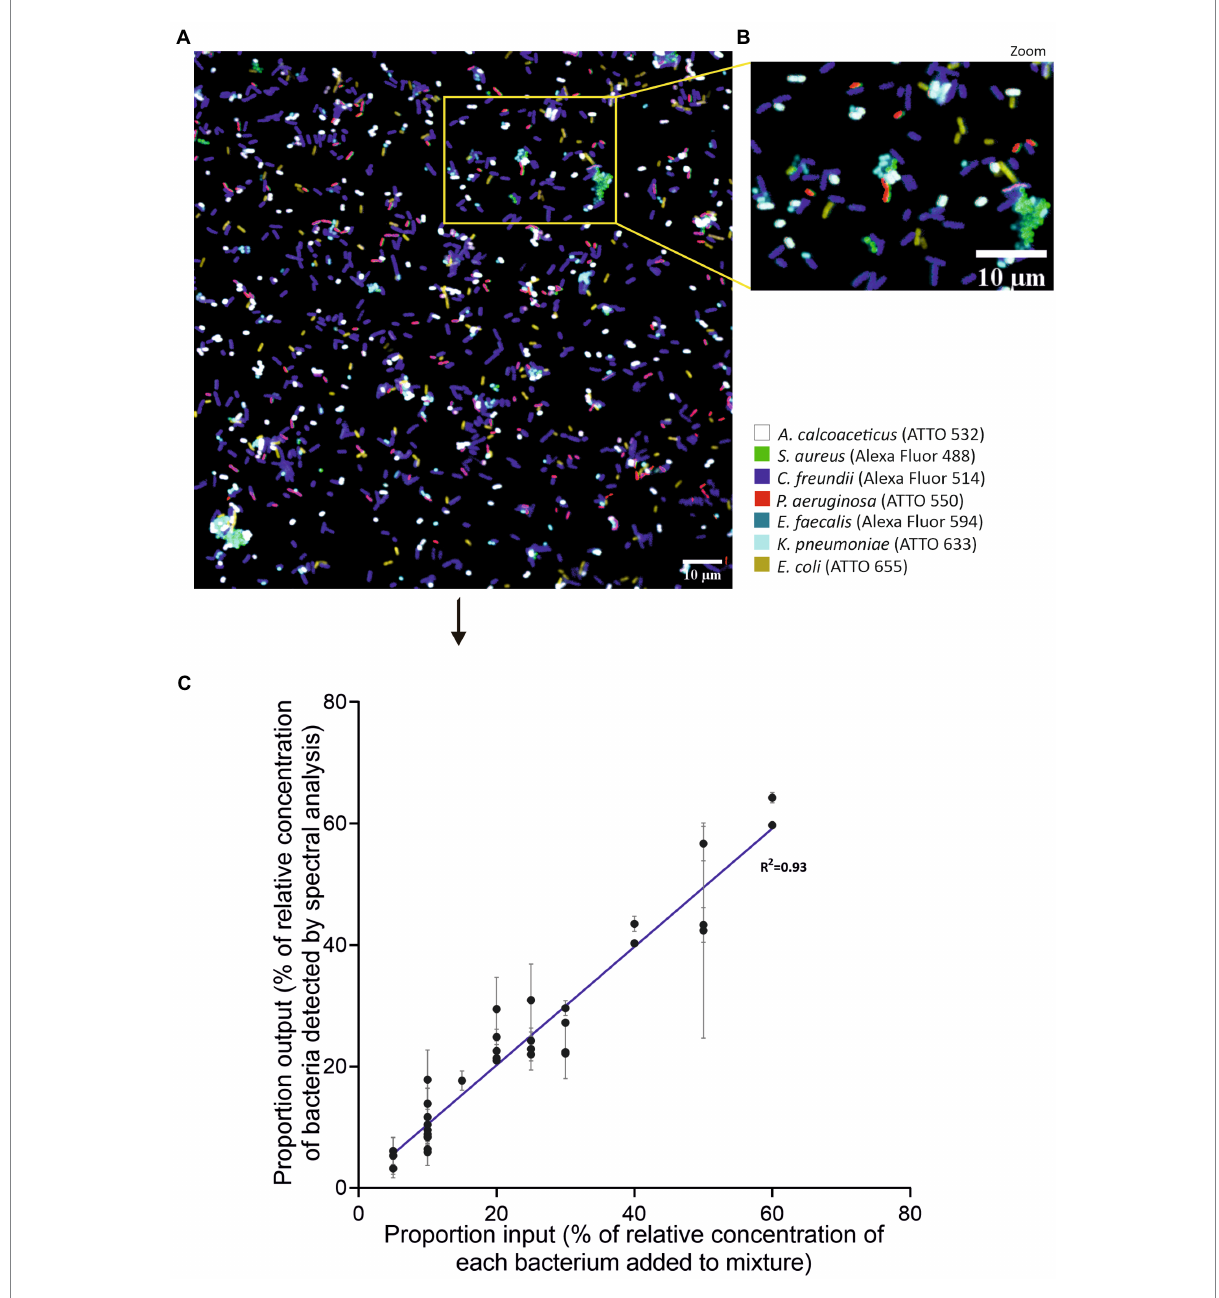
FIGURE 5 Validation of SI-NAM-FISH proof-of-principle using seven species-specific LNA/2’OMe probes. Unmixed image of a mixture of seven different bacteria labeled species-specific LNA/2’OMe probes attached to Alexa Fluor 488 (green, S. aureus ), Alexa Fluor 514 (magenta, C. freundii ), ATTO 532 (white, A. calcoaceticus ), ATTO 550 (red, P. aeruginosa ), Alexa Fluor 594 (blue, E. faecalis ), ATTO 633 (turquoise, K. pneumoniae ), and ATTO 655 (yellow, E. coli ). The image corresponds to a merge of all seven fluorochromes channels after linear unmixing (A) . Enlarged part of the image (B) as indicated by the frame in panel (A) . The bacteria, fluorochromes, and assigned false colors are indicated. Correlation between the percentage of relative concentration of each bacterium added to the mixture and the percentage of relative concentration of bacteria detected by spectrally acquired microscope images after application of a linear unmixing algorithm (C) . Error bars represent standard deviation from two different fields of view of the same artificial